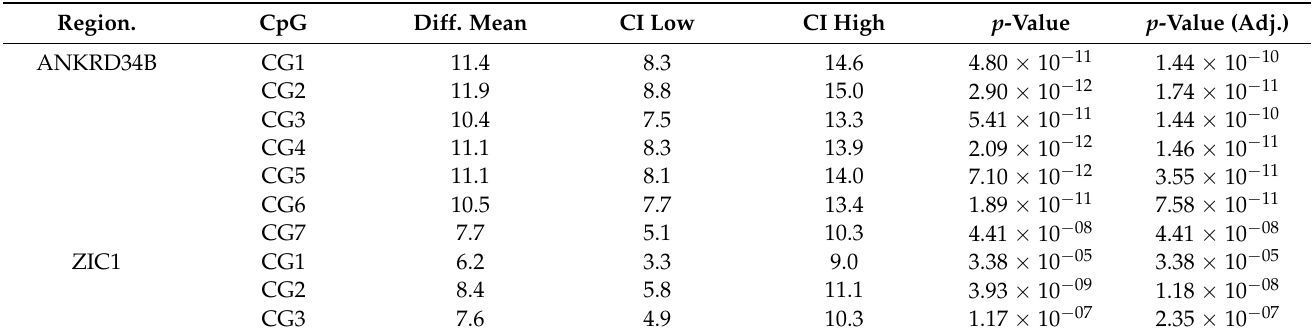
Table 3. CpG site-specific statistical comparison of paired tumor adjacent normal and tumor tissue samples using the two-sided t -test.